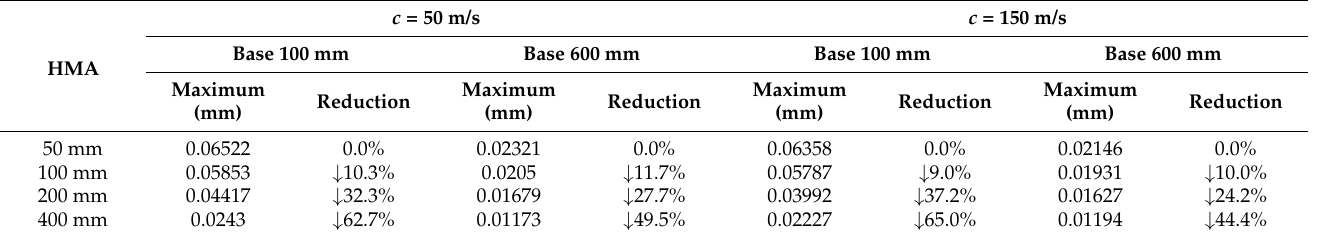
Figure 10. Effect of the HMA thickness on the vertical displacement fluctuation amplitude along the x -axis, induced by a moving Gaussian load: ( a ) cases for a 100mm-thick base layer, with a speed of c = 50 m/s; ( b ) cases for a 100 mm-thick base layer, with a speed of c = 150 m/s; ( c ) cases for a 600 mm-thick base layer, with a speed of c = 50 m/s; and ( d ) cases for a 600 mm-thick base layer, with a speed of c = 150 m/s. Table 1. Reduction in the maximum displacement for different variations in the HMA layer